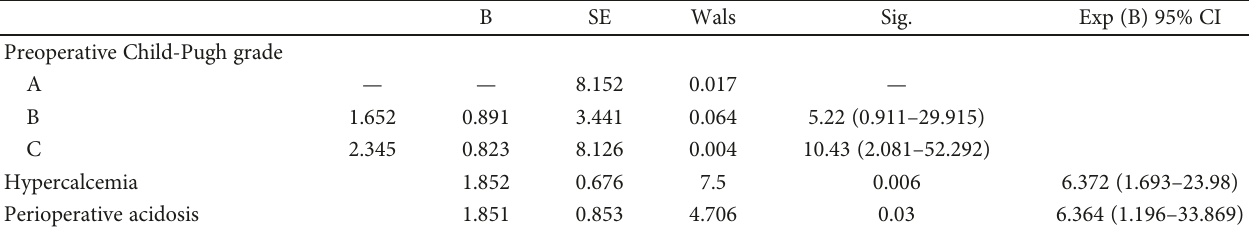
Table 8: Multivariate logistic analysis for the incidence of sepsis after orthotopic liver transplantation